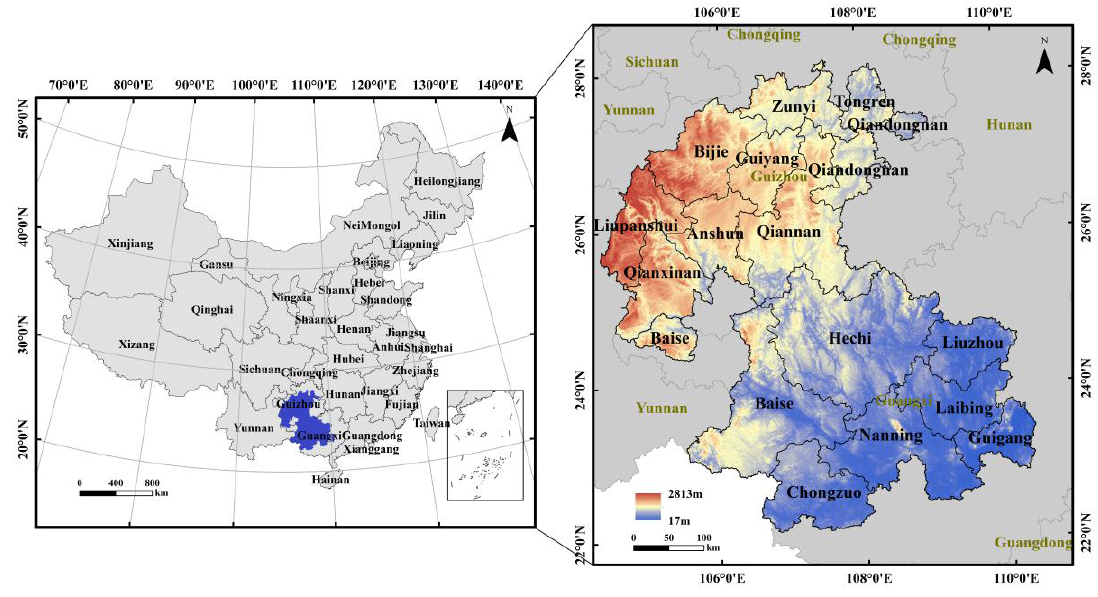
Figure 3. Geographic position of the study region.